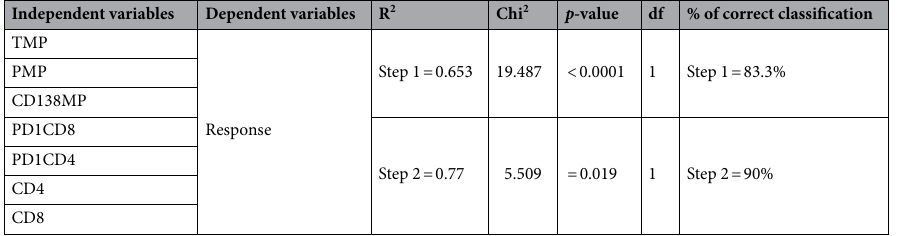
Table 8. Model summary of logistic regression done for 30 patients with MM. Response is a binary variable with two categories; 0; non CR, 1; CR, df; degrees of freedom, p < 0.05.